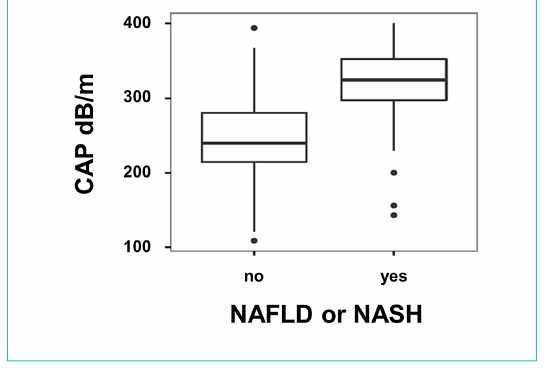
Figure 4: Comparison of controlled attenuation parameter (CAP) values in patients with body mass index (BMI) <25 kg/m 2 (median 229 dB/m) vs BMI ≥25kg/m 2 (median 280 dB/m).